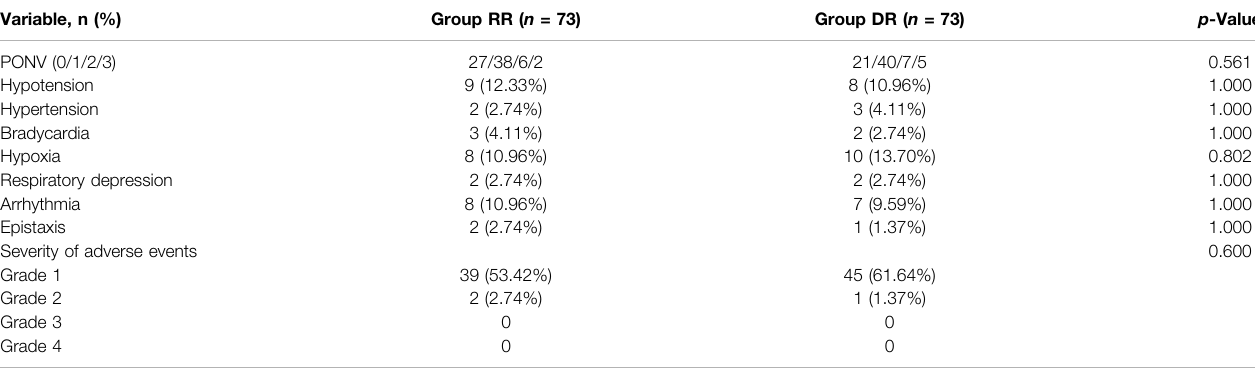
TABLE 4 | Adverse